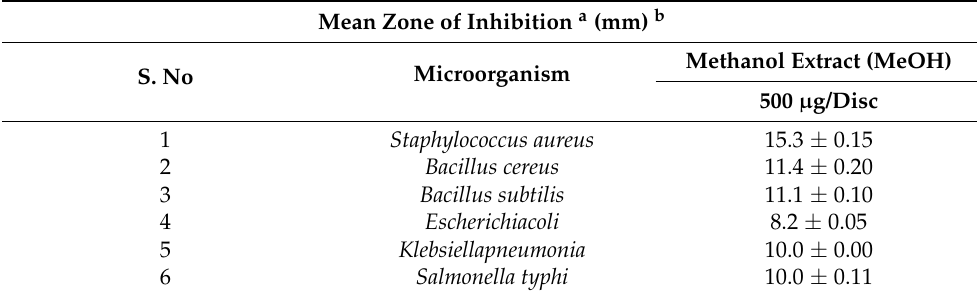
Table 1. Antibacterial activities of MeOH leaf extract from the AT (500 µ